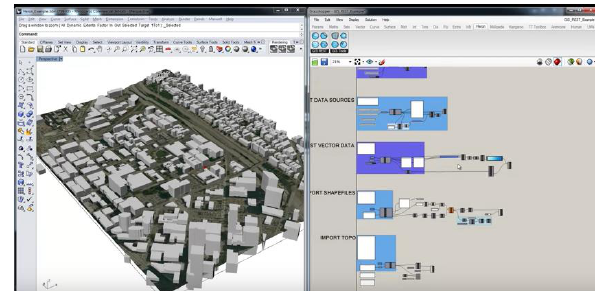
Figure 3. Grasshopper`s Heron plugin interface